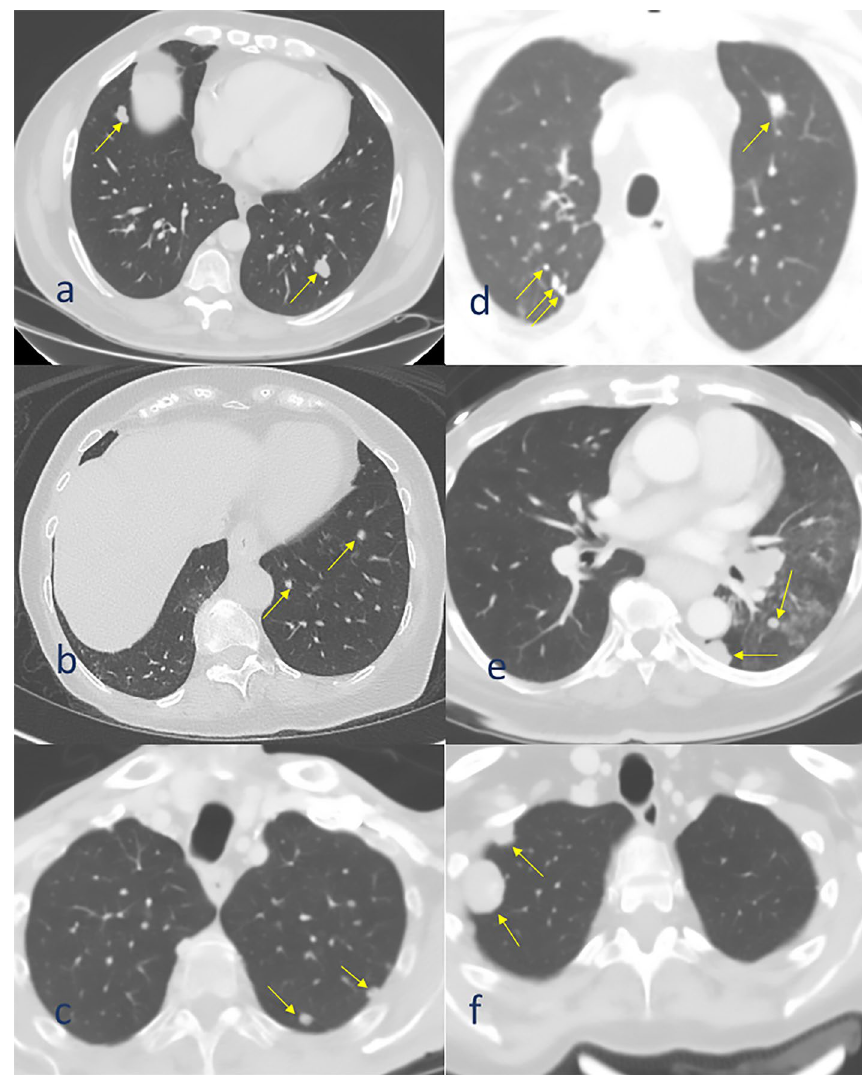
Fig. 3 Representative scans of patients diagnosed with a few metastases with similar diameters representing a sin- gle (presumably monoclonal spread) cluster. a-liposarcoma, b-pancreas, c-stomach. These patients are suitable for inclu- sion in an oligometastasis trial. Patients were diagnosed with few metastases but with different diameters (presum- ably representing multiclonal spread) d-colorectum, e-melanoma, f-osteosarcoma. Despite having only a few metastases, these patients may not be suitable for inclu- sion in an oligometastasis